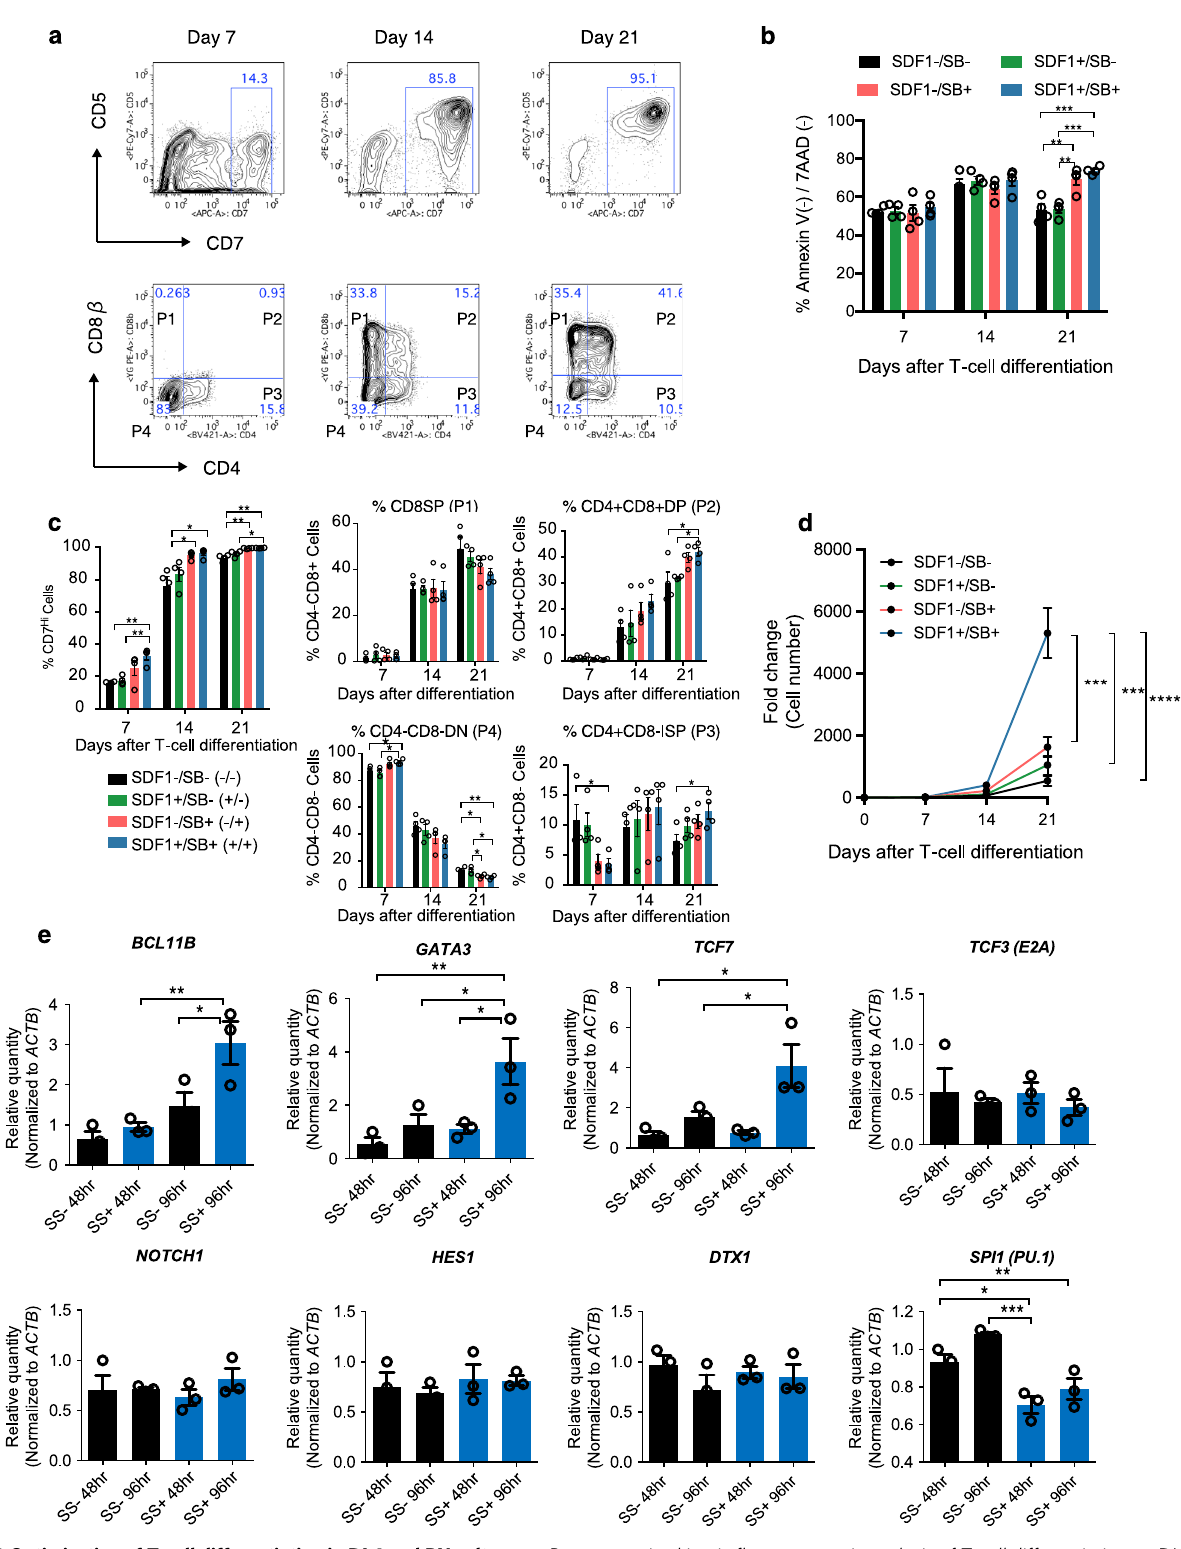
Fig. 2 Optimization of T-cell differentiation in DL4 and RN cultures. a Representative kinetic fl ow cytometric analysis of T-cell differentiation on DL4 and RN cultures assessed at the indicated days. b Frequencies of Annexin V(-)/7-AAD (-) live cells in differentiating cultures over 3 weeks in the presence or absence of SDF1 α and/or SB203580 ( n = 4). c Frequencies of the indicated cell types de fi ned as in ( a ) in the differentiation culture over 21 days in the presence or absence of SDF1 α and/or SB203580 ( n = 4). d Kinetics of differentiating T-iPSC-HPC counts over 21 days on DL4 and RN in the presence or absence of SDF1 α and/or SB203580 ( n = 4). e Gene expression related to T-cell differentiation, Notch signaling pathway, and a myeloid lineage gene (SPI1 (PU.1)) detected by qPCR after T-iPSC-HPCs were cultured for 48 or 96 h on DL4 and RN + / − SS ( n = 3). Data represent mean ± SEM of n independent experiments. * P < 0.05; ** P < 0.01; *** P < 0.001 by one-way ANOVA with Tukey ’ s multiple comparison test.